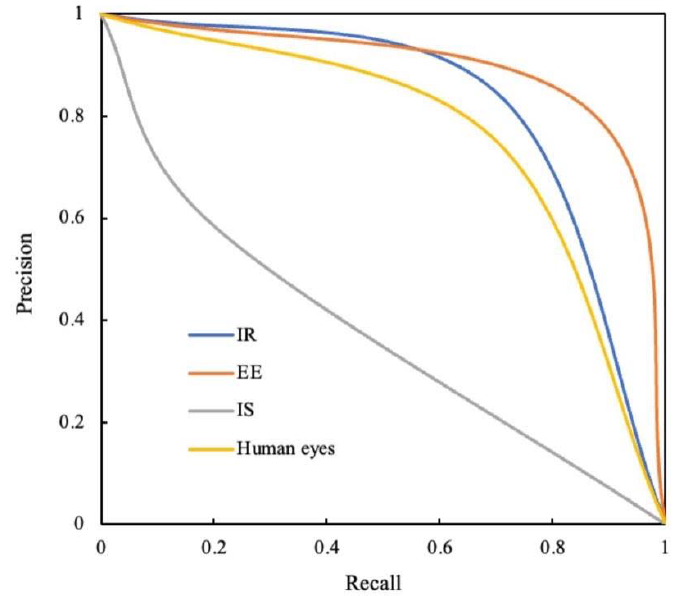
Figure 4. The P-R curves of different recognition modes and human eyes. P-R = precision-recall; IR = image recognition; EE = edge extraction; IS = image segmentation.